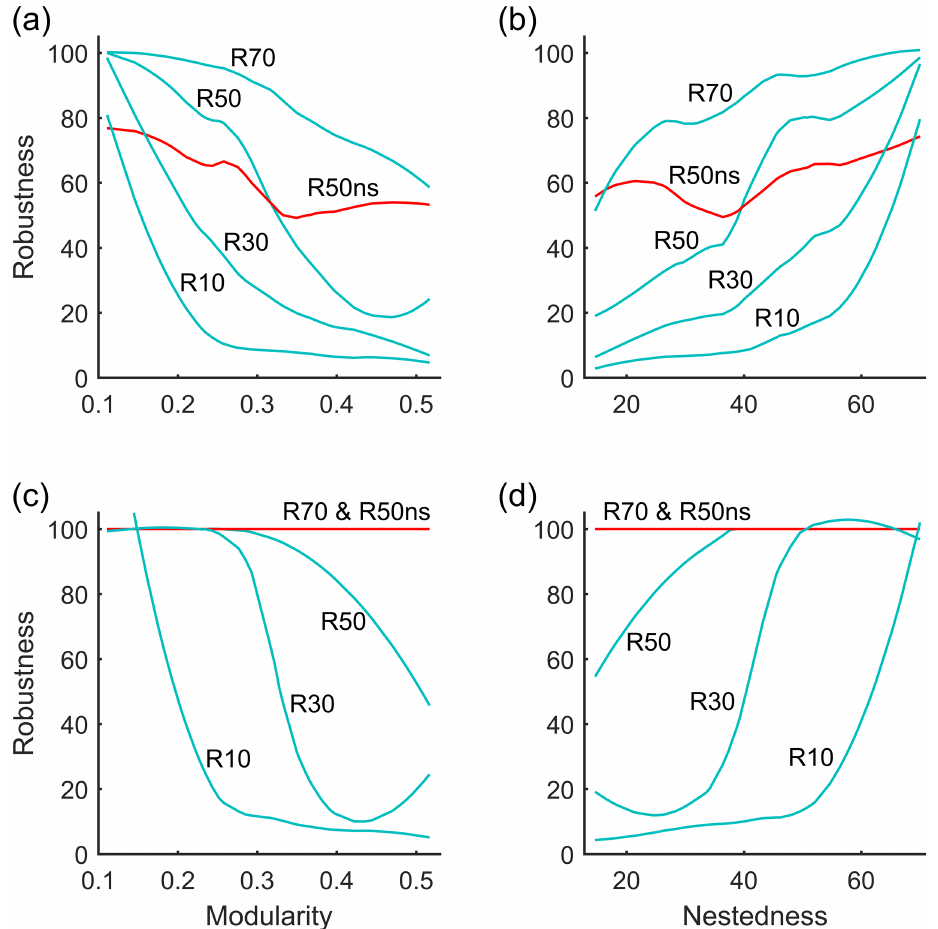
Fig 5. Genaralised additive model lines of fit of robustness with different threshold percentages on modularity and nestedness. R10—R70 correspondto the percentageof resources that need to be removed before at least 10–70%of consumer species go extinct in an adaptive network whileR50ns corresponds to the percentage of resources that needto be removedbefore at least 50% of consumerspecies go extinct in a rigid network. Panels (a) and (b) indicate the removal of generalists while(c) and (d) indicatethe removalof specialists.